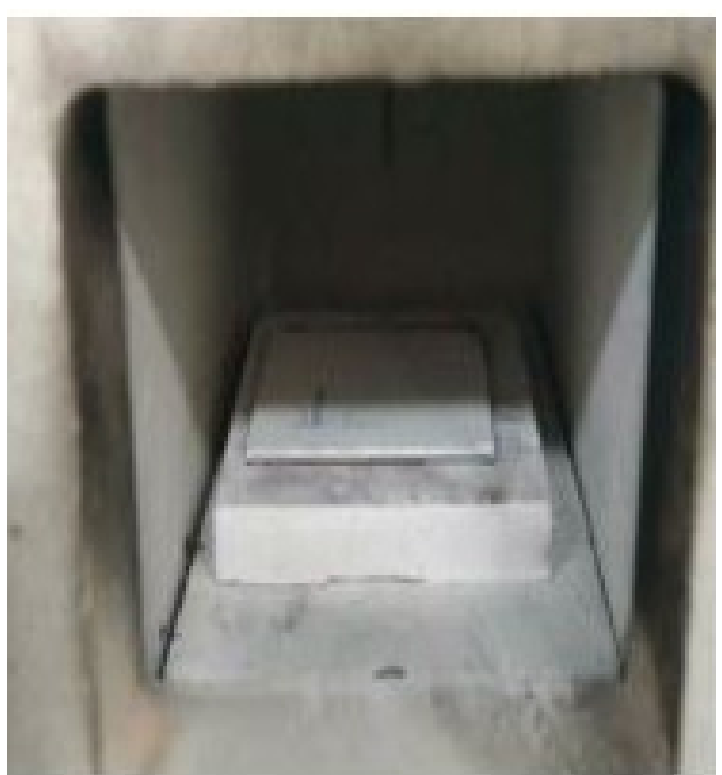
Figure 1. Electric furnace.